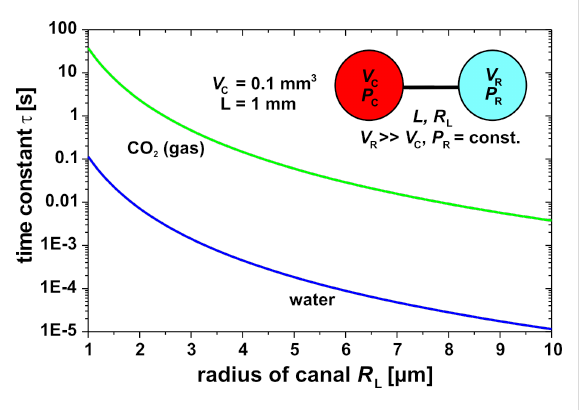
Figure 13: Comparison of time constants for a compensation leak of a cavity filled with water or with CO 2 gas as a function of the radius of the